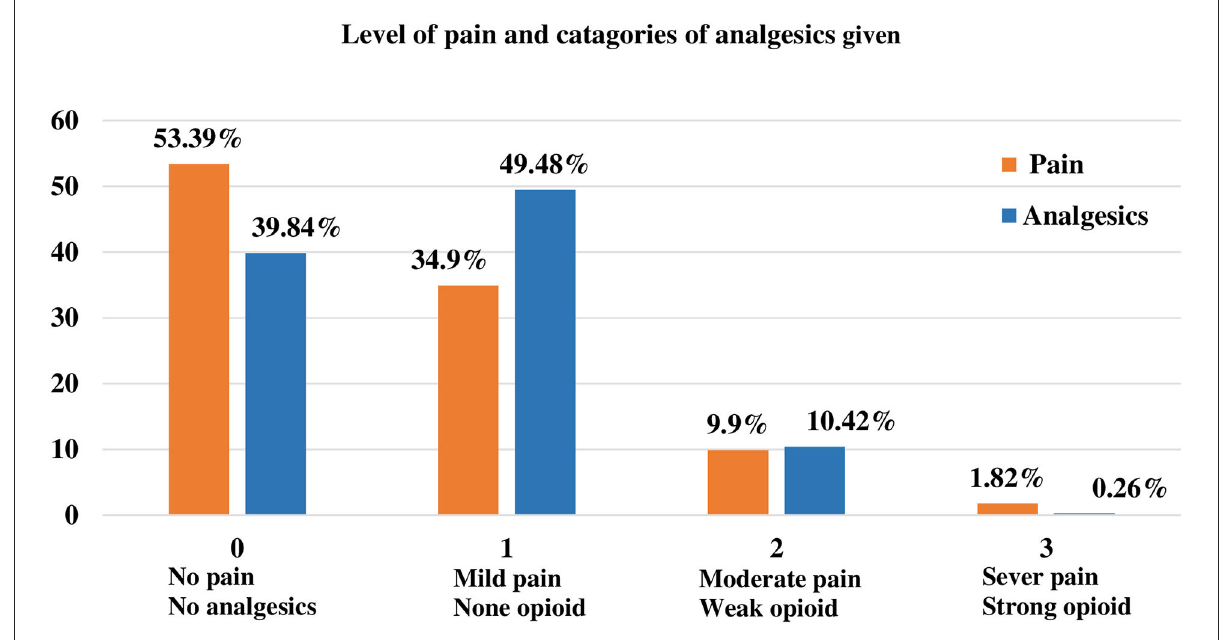
FIGURE1 The proportion of the level of pain and categories of analgesics were given.